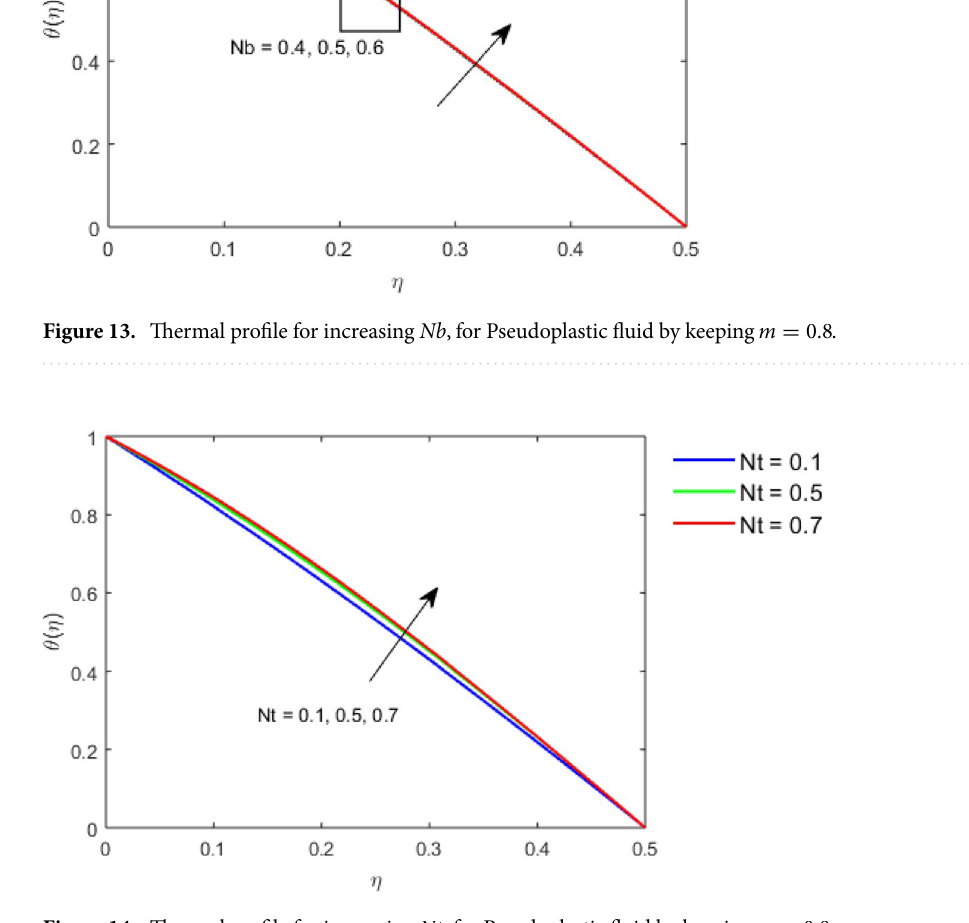
Figure 14. Thermal profile for increasing Nt , for Pseudoplastic fluid by keeping m = 0.8